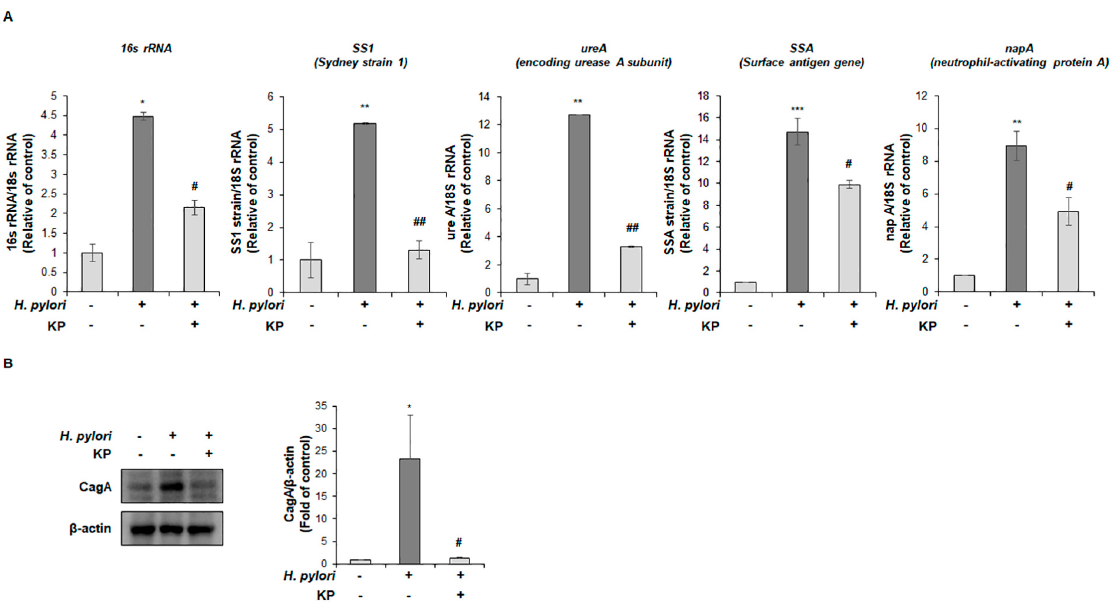
Figure 2. KP attenuates H. pylori virulence factors in H. pylori -infected gastric mucosal injury mice model. ( A ) mRNA expression levels in gastric mucosal tissues were examined via qRT-PCR. As an internal control, 18S rRNA was used for the expression of H. pylori -related genes. ( B ) The protein expression of CagA in gastric mucosal tissues was determined by Western blotting. β -actin was used as an internal control. Data are the mean ± standard deviation ( n = 4). Statistical significance was analyzed by analysis of variance. * p < 0.05 and ** p < 0.01, and *** p < 0.001 vs. normal group; # p < 0.05 and ## p < 0.01 vs. H. pylori group, significantly different compared with